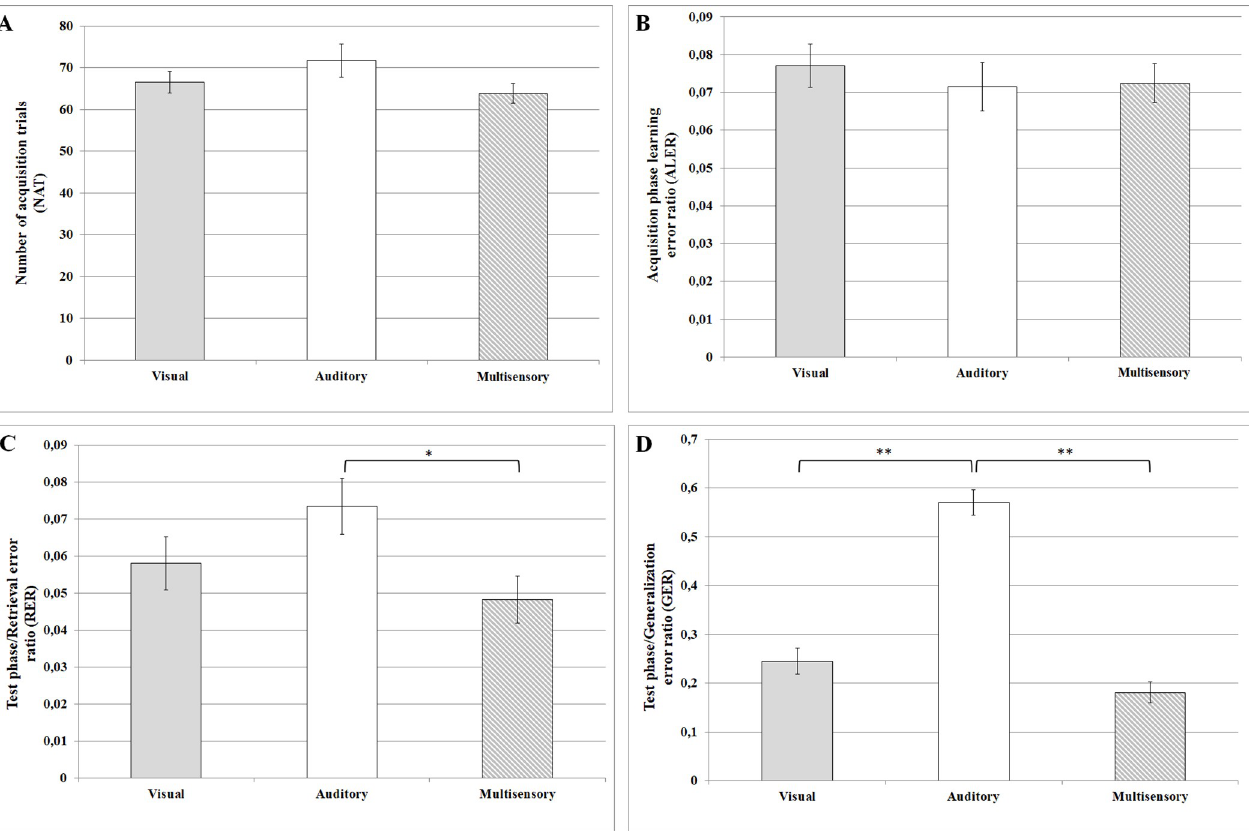
Fig 2. Performances in the sensory guided equivalence learning paradigms. (A) denotes the number of the necessary trials in the acquisition phase of the paradigm. (B) shows the error ratios in the acquisition phase of the paradigm. (C) and (D) denote the error ratios in the retrieval and generalization parts of the test phase, respectively. In each panel, the first column (light grey) shows the results in the visual paradigm, the second column (white) denotes the results in the auditory paradigm and the third column (grey-white striped) demonstrates the results in the multisensory (audiovisual) paradigm. Mean ± SEM values are presented in each column. The black stars denote the significant differences. The single star in part C represents a significant difference, where p < 0.05; the two stars in part D represent strongly significant differences, where p <